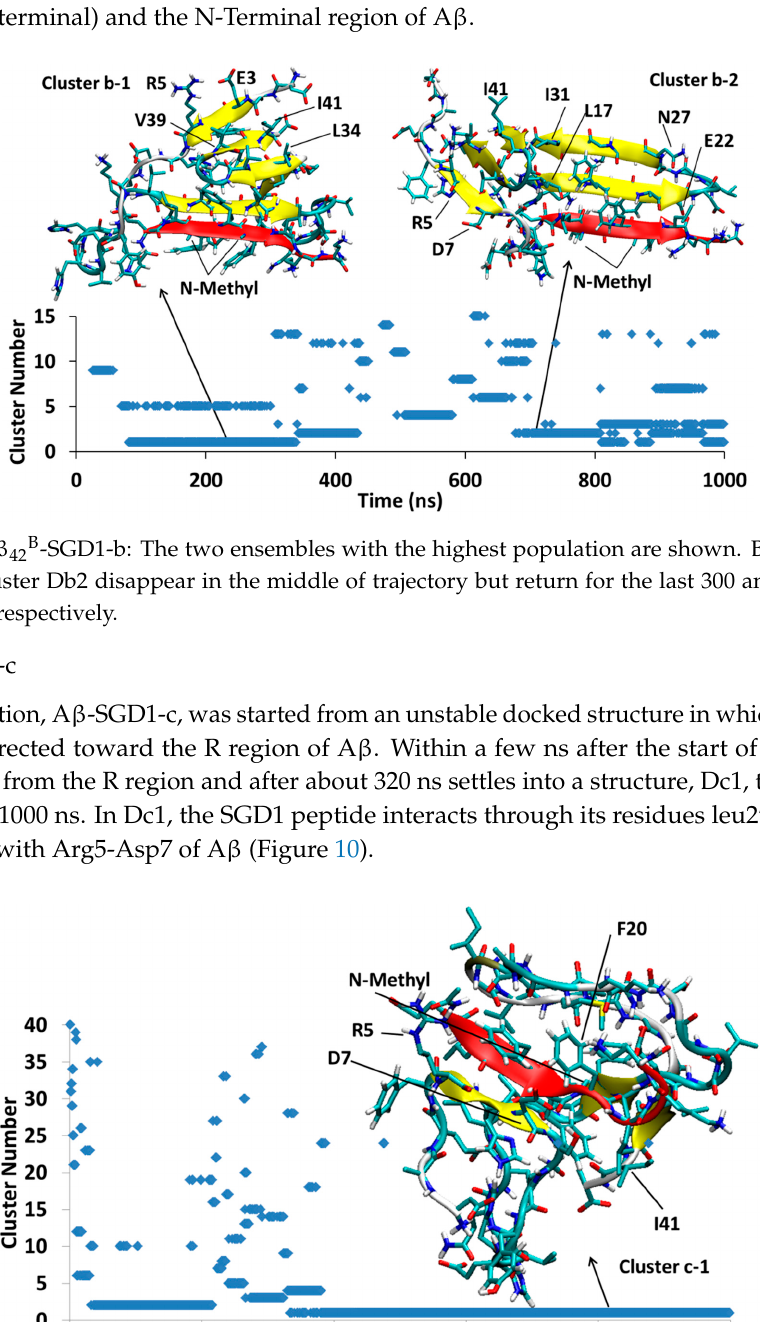
Figure 11. A β B -SGD1-d. Clusters Dd1, Dd2, Dd3 and Dd5 are shown. Cluster Dd2 makes a transition to structure Dd3 which exists through 321–465 ns. The main intermolecular interaction is similar to cluster Dd2, where the parallel β -sheet is observed between Val18-Asp23 and leu2 ′ -orn7 ′ . This intermolecular interaction is observed also for next clusters, Dd1